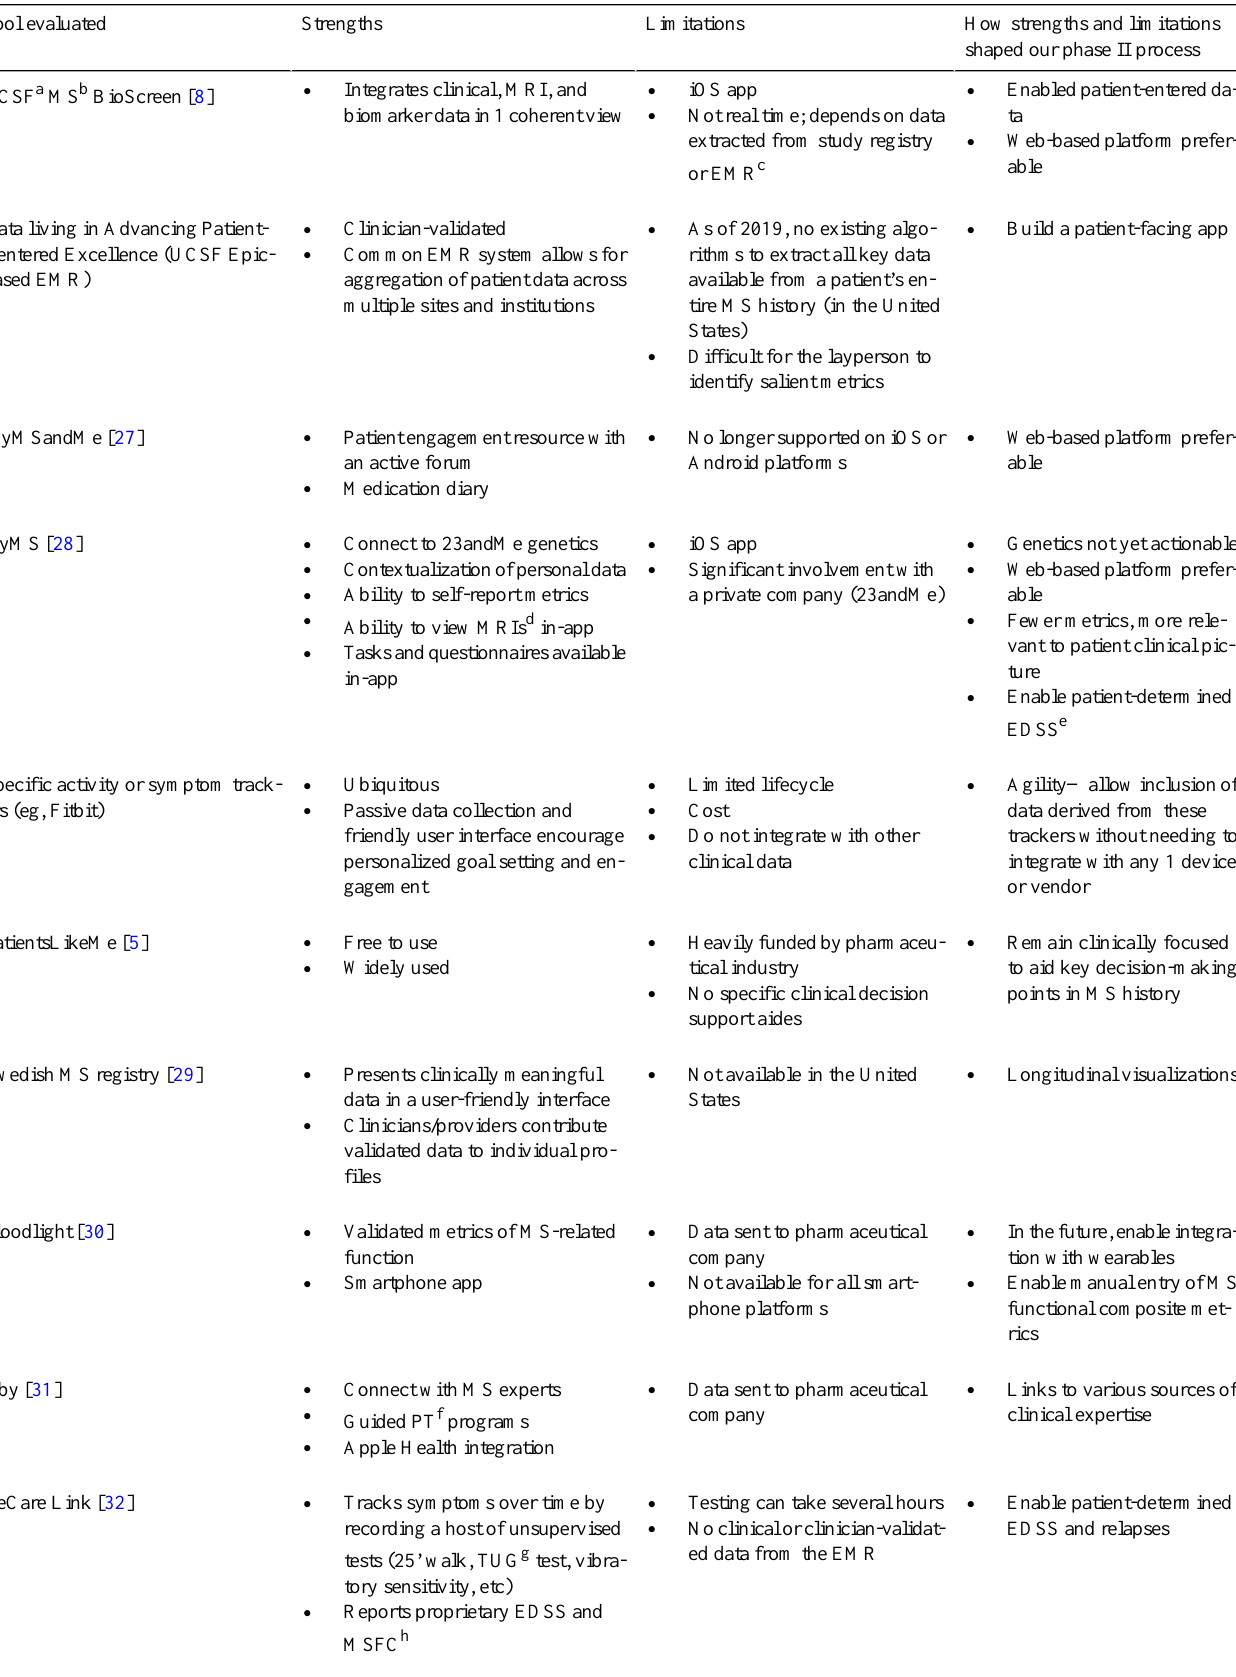
Table 2. Comparative analysis of existing technological solutions: illustrative